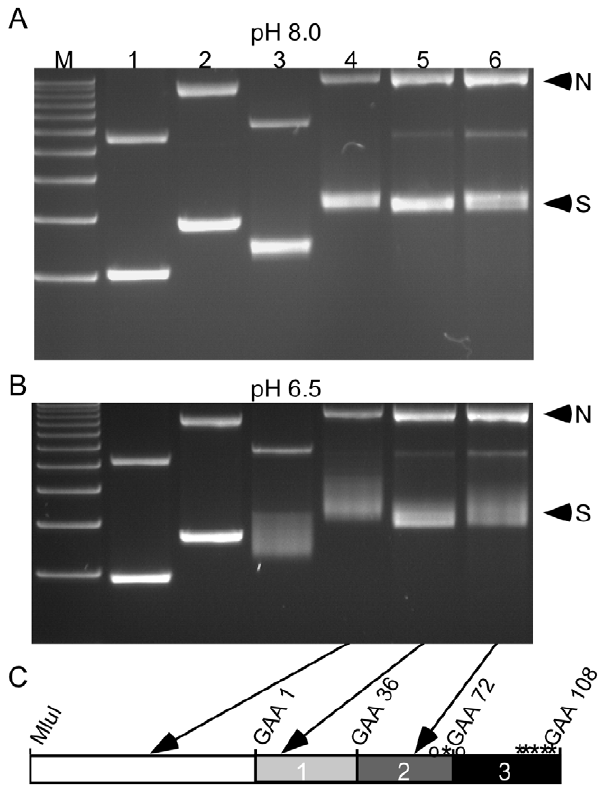
Figure 4. Interruptions in the GAA N TTC repeat alter pH dependent formation of secondary structure. The electrophoretic mobility of nicked (N) and supercoiled (S) plasmids at pH 8.0 and pH 6.5 is shown in A and B, respectively. M=1KB plus ladder, Lane 1:9 repeats, no transposon. Lane 2:9 repeats and Tn5 transposon 5 9 of the first repeat. Lane 3:108 repeats, no transposon. Lane 4:108 repeats and transposon Tn5 86 bases 5 9 of the first repeat. Lane 5:108 repeats and transposon at repeat 8. Lane 6:108 repeats and transposon at repeat 57. Arrows indicate the repeat region containing the Tn5 transposon in plasmids run in lanes 4, 5 and 6 on the schematic representation of the repeat target in panel C. The size of the plasmid in lane 1 is 4815 bp; in lane 2, 6328 bp; in lane 3, 5100 bp; in lanes 4–6 6613 bp.